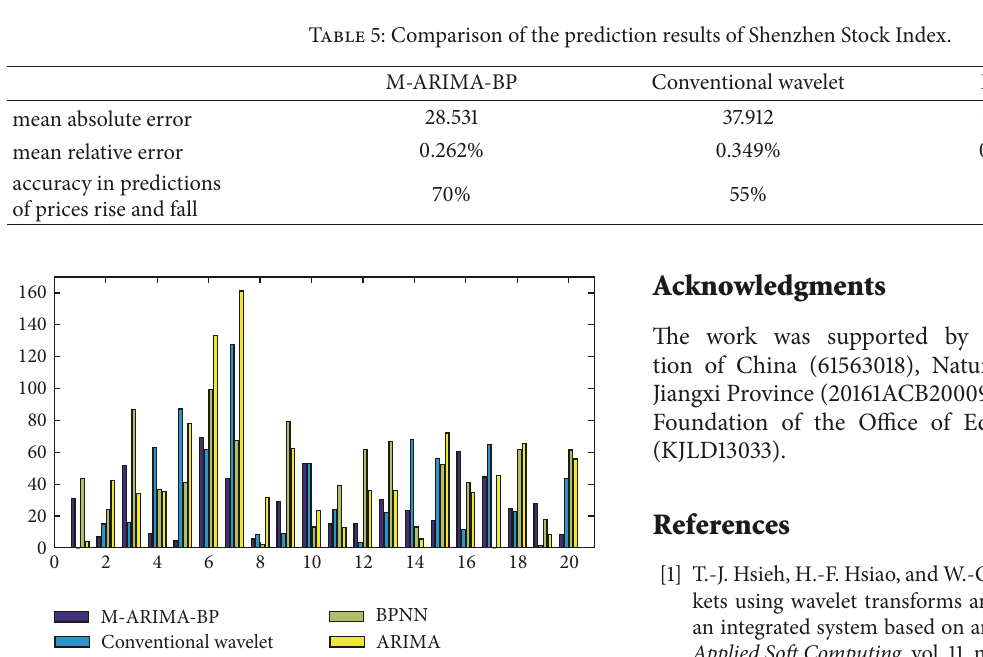
Figure 13: Absolute error of single point prediction of Shenzhen Stock